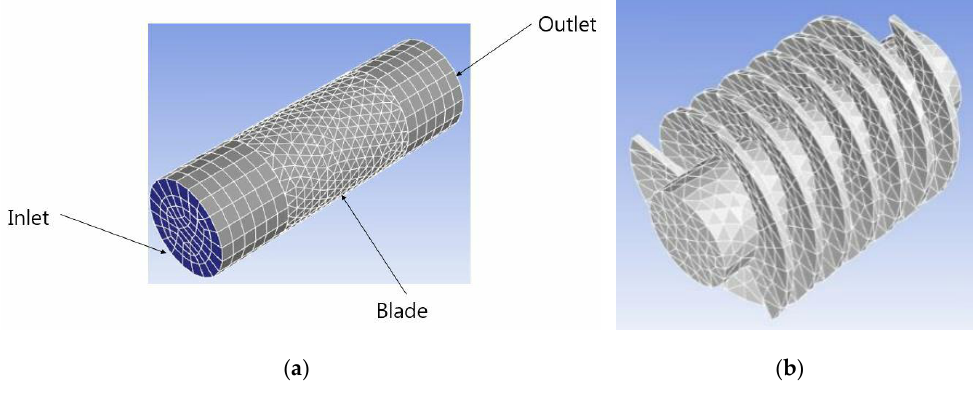
Figure 10. CFD Mesh: ( a ) mesh; ( b ) blade mesh.